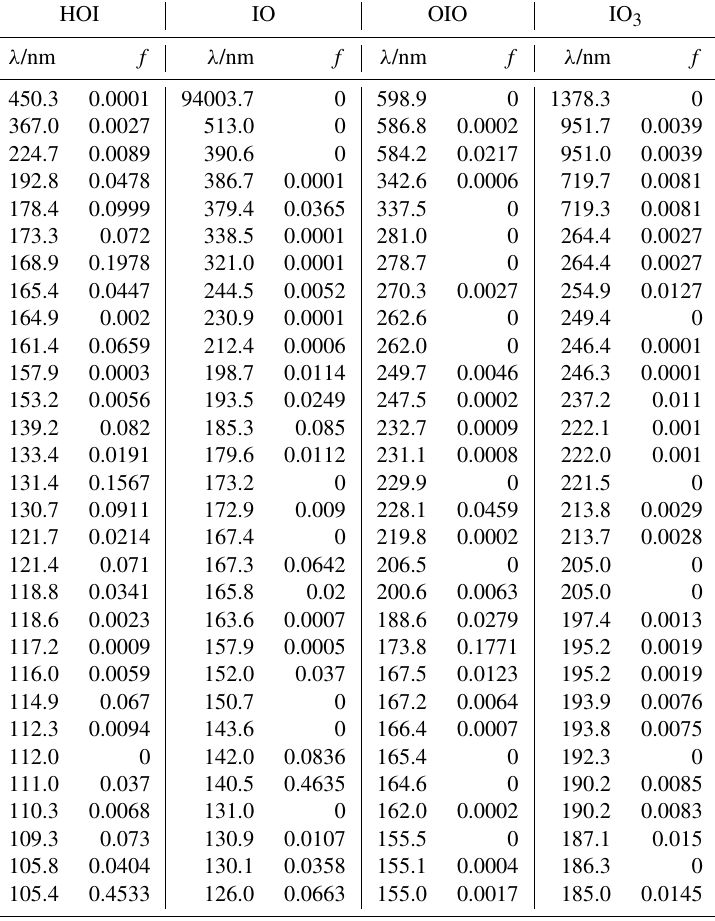
Table A2. Peak wavelengths and oscillator strengths ( f ) for the first 30 excited states of HOI, IO, OIO, and IO 3 at the TD/B3LYP/G2 level of